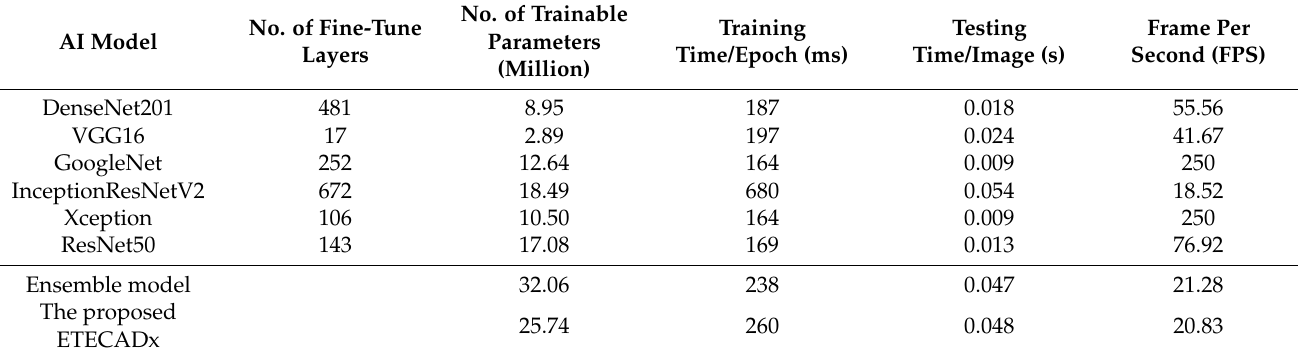
Table 8. Performance comparison of the proposed ensemble learning and the hybrid ETECADx models against the individual AI models to the computation costs in binary